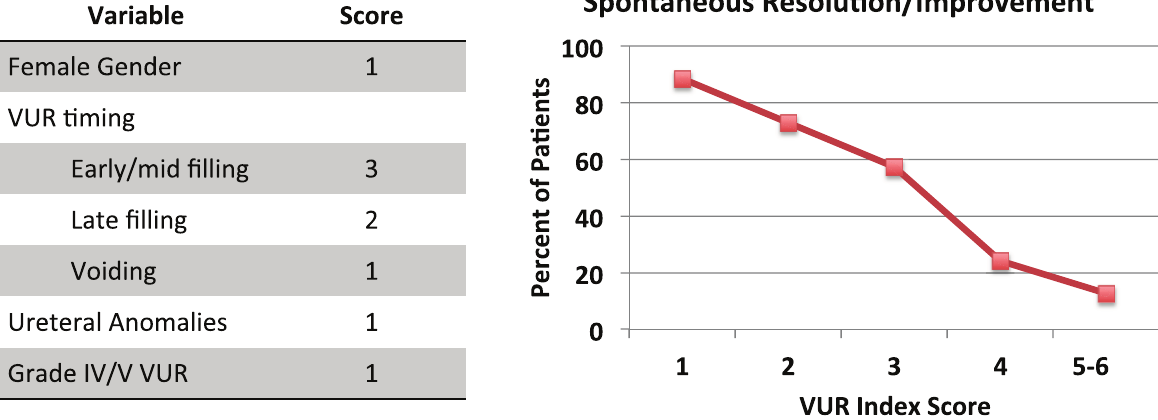
Figure 2. Vesicoureteral reflux (VUR) index with associated weighted scoring system predicts VUR improvement or resolution in children diagnosed with VUR <2 years old. The rate of resolution or improvement is outlined in the graph of improvement rate based on VUR index score. The graph represents an average of the initial VUR index cohort and subsequent multi-institutional VUR index validation cohort.